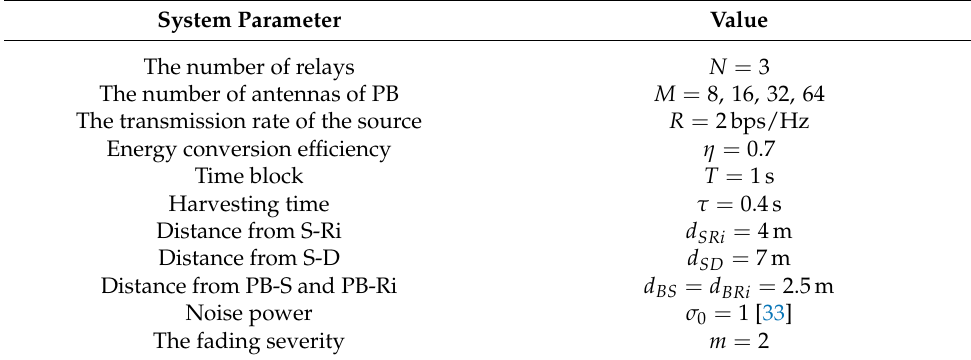
Table 1. System parameters used in the performance